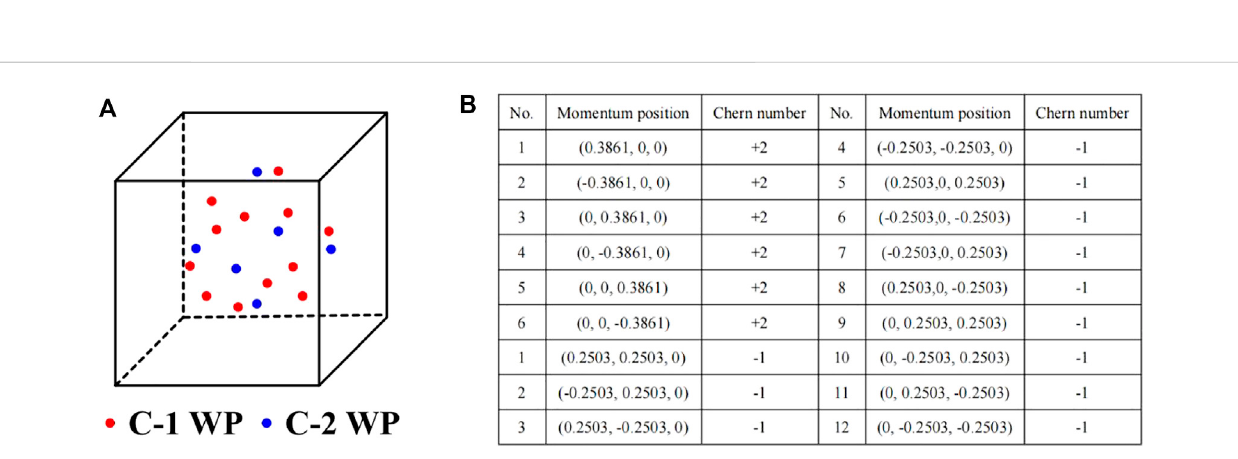
FIGURE 3 (A) and (B) positions for the 12 C-1 WPs and 6 C-2 WPs in the 3D